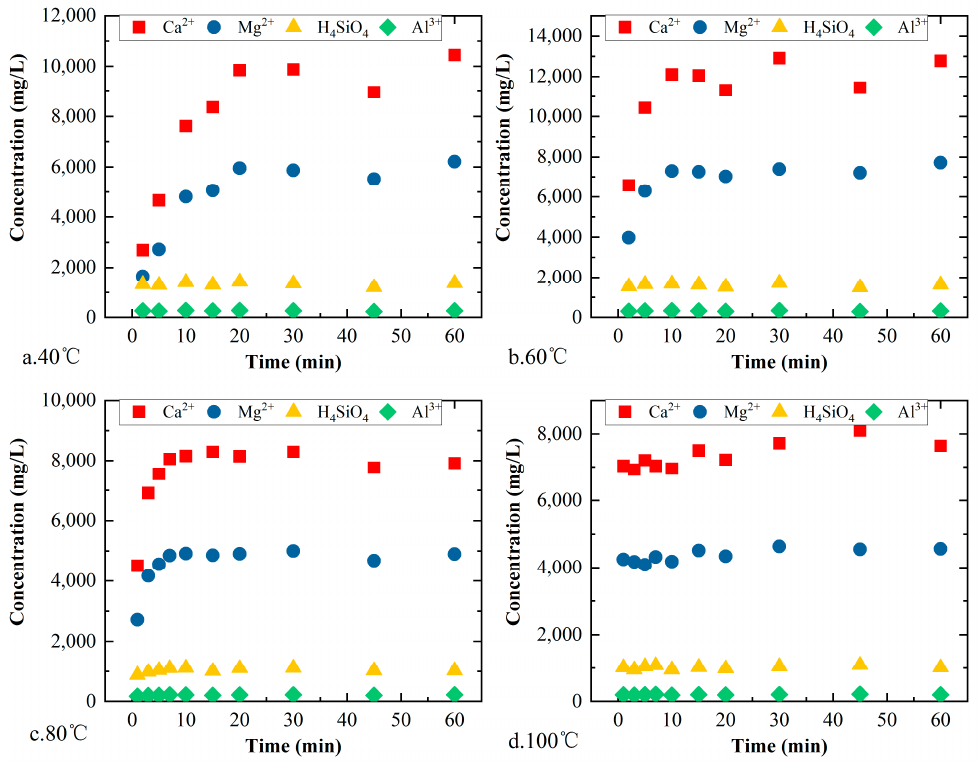
Figure 9. Ion concentrations in acid after the reaction of core R3 reaction at ( a ) 40 °C; ( b ) 60 °C; ( c ) 80 °C; ( d ) 100 °C.